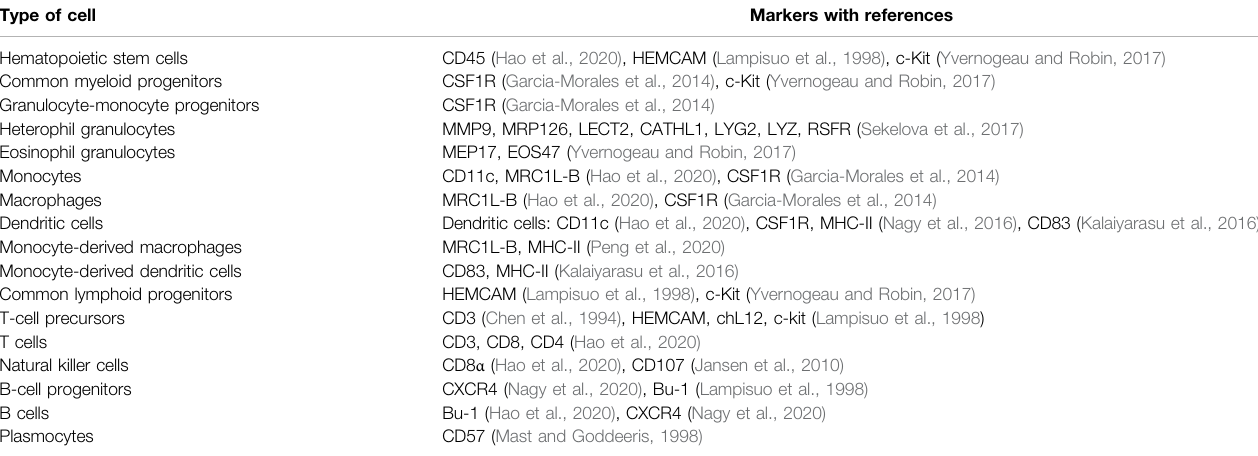
TABLE 1 | Distinctive markers of chicken immune cells derived from hematopoietic stem